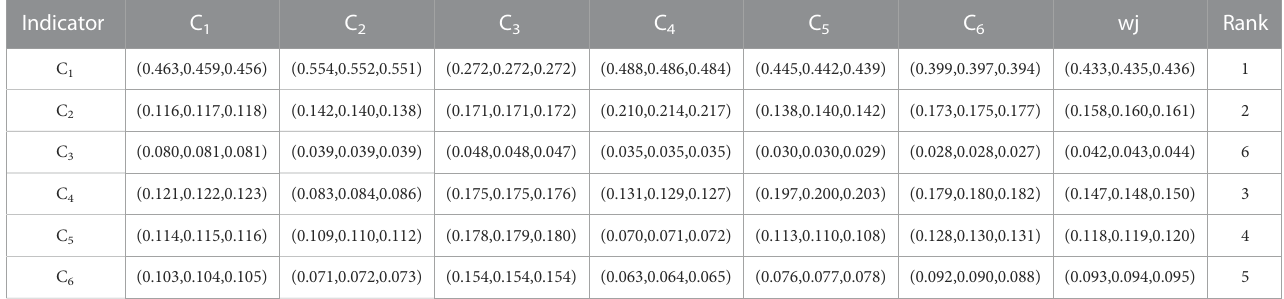
TABLE 12 Standard weight and ranking of installation and construction factor layers